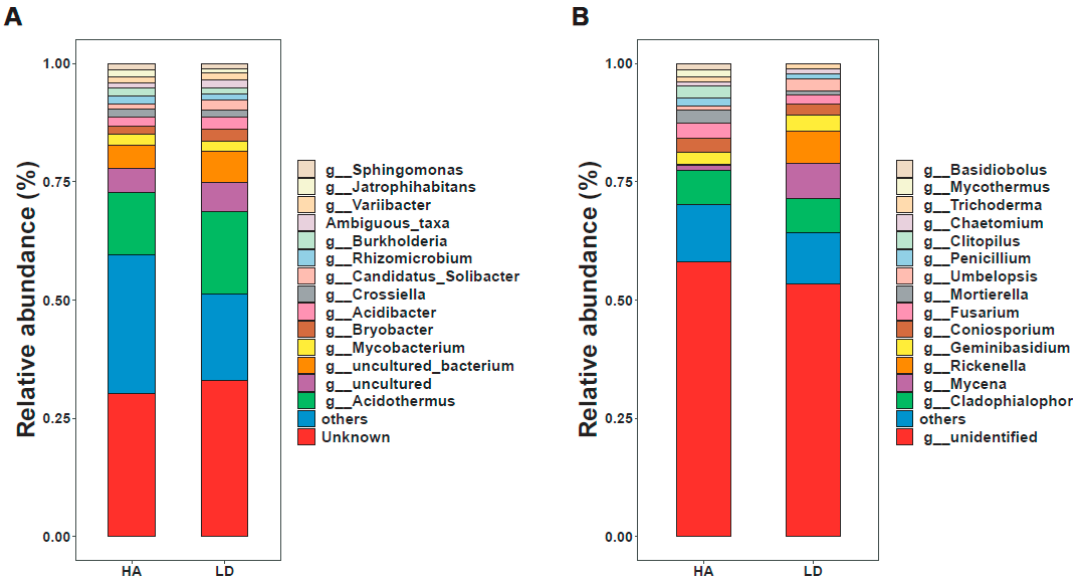
Figure 3. Relative abundance of bacteria ( A ) and fungi ( B ) at the genus level. LD and HA represent the absence and presence of humic acid in diseased bayberry trees, respectively.